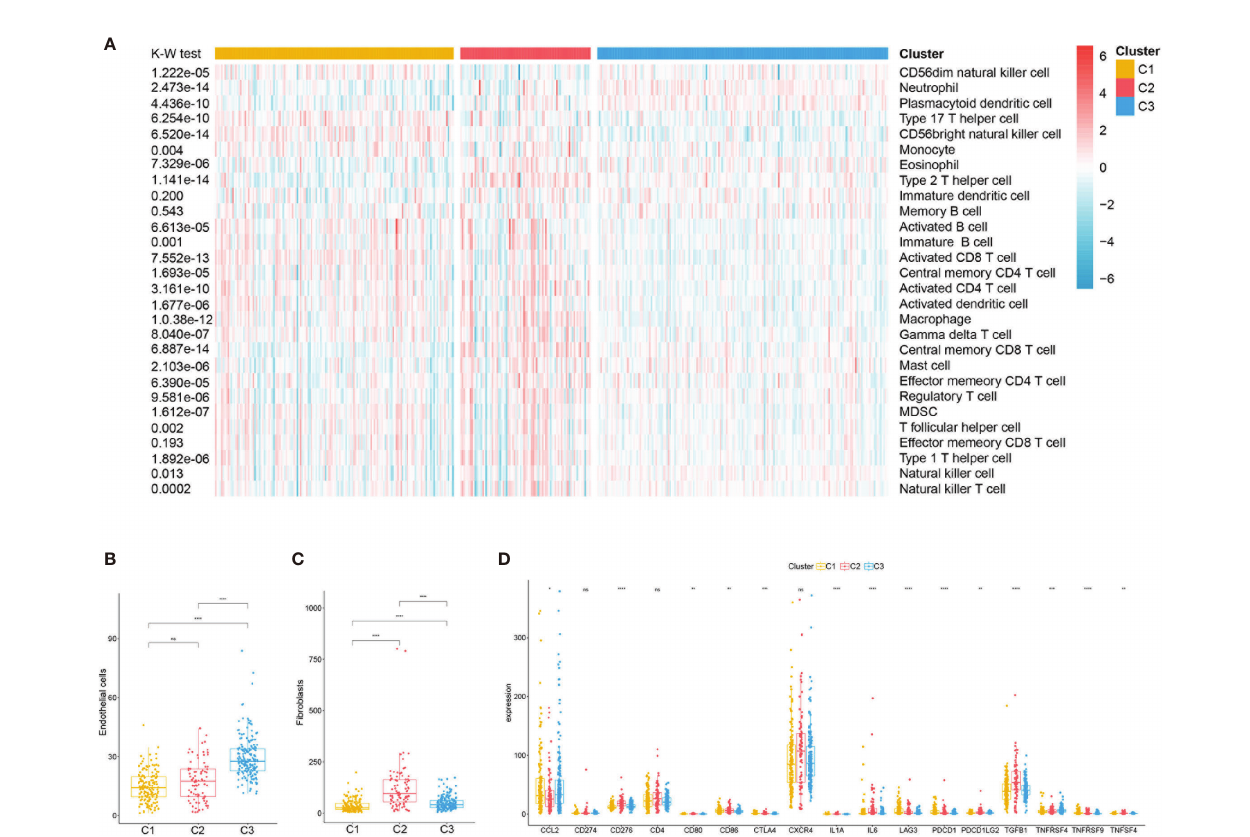
FIGURE 5 | Immune characteristics of the three subclasses in The Cancer Genome Atlas (TCGA) training set. (A) Heatmap describing the abundance of immune cell populations in C1, C2, and C3. Box plot of the abundance of endothelial (B) and fi broblasts (C) distinguished by different subclasses. (D) Expression levels (in fragments per kilobase of transcript per million mapped reads, FPKM) of 17 immune checkpoint genes in the three clear cell renal cell carcinoma (ccRCC) subclasses. ns , no signi fi cance. * p < 0.05, ** p < 0.01, *** p < 0.001, **** p <